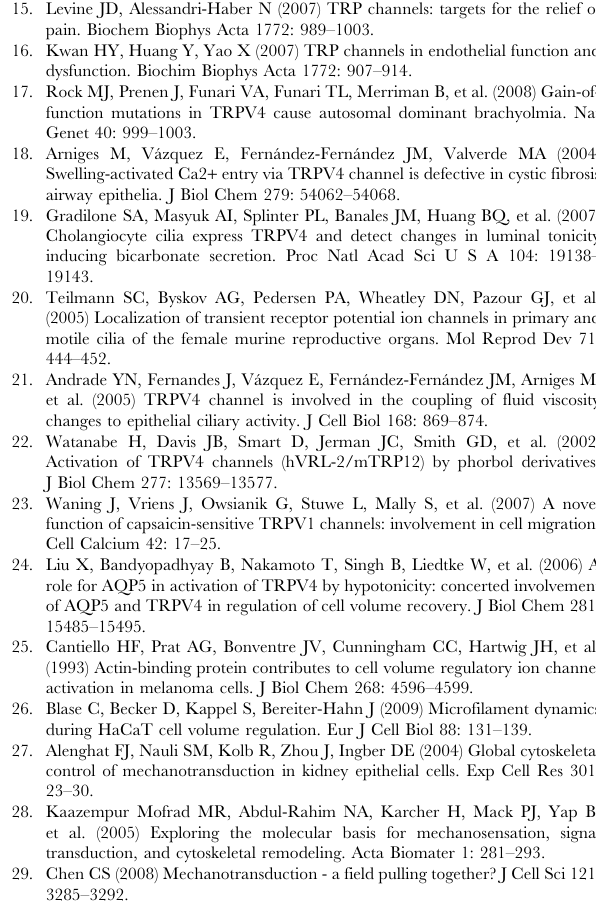
buffer and fixed. Cells were immunostained for TRPV4 (green) and tubulin (red). In absence of activation, TRPV4 expressing cells retains all the microtubules (upper panel, i-iii), but lost all the distal microtubules if activated with 4 a PDD (middle panel, iv-vi). The stable MTOC region is marked with an arrow. Note that non- transfected cells retain all the microtubules even after addition of 4 a PDD (lower panel). b. CHO-KI cells expressing TRPV4 (green) were activated with 4 a PDD (1 m M) and were further extracted with detergent in isotonic buffer and fixed. Under this condition, nontransfected cells show microtubules all over the cells, while transfected cells contain very little microtubules. Figure S6 TRPV4 localization at membrane is not affected by Taxol. Shown are the confocal images depicting the distribution and co-localization of TRPV4 (green) and tubulin (red) in Cos7 cells. Cells expressing TRPV4 were fixed under control condition (i), fixed after incubation with Taxol for 30 minute (ii) or incubation with Nocodazole for 30 minutes (iii). Cells were immunostained for TRPV4 (green) and tubulin (red). The white line indicates the periphery of the cell. All these images were acquired at an identical laser power and gain value. Figure S7 Microtubule stabilization by Taxol does not alter the surface distribution of TRPV4. To confirm that Taxol-treated cells still contain TRPV4 at the cell surface, we performed surface biotinylation of TRPV4-GFP expressing Cos7 cells that